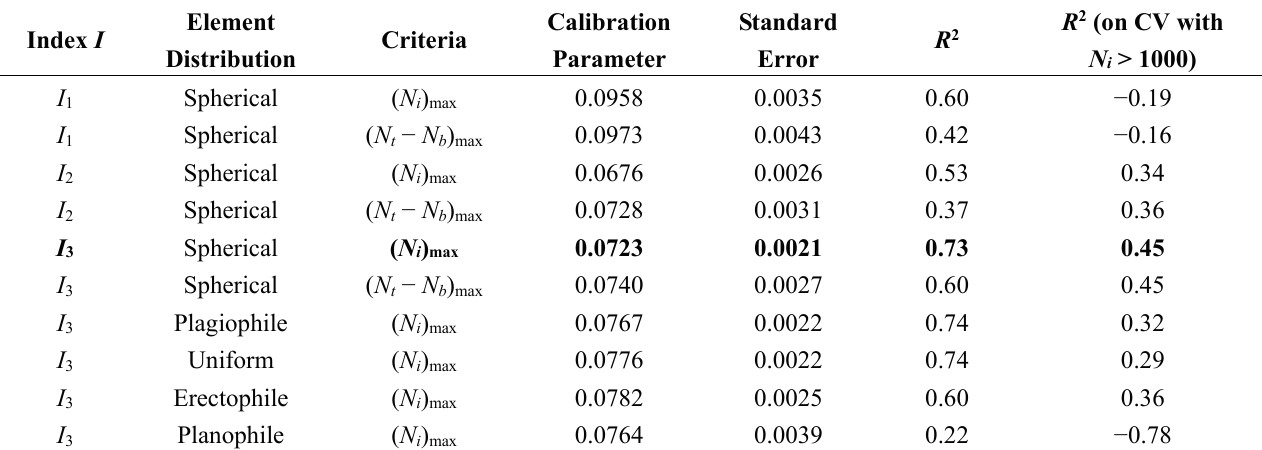
Table 3. Bulk density model